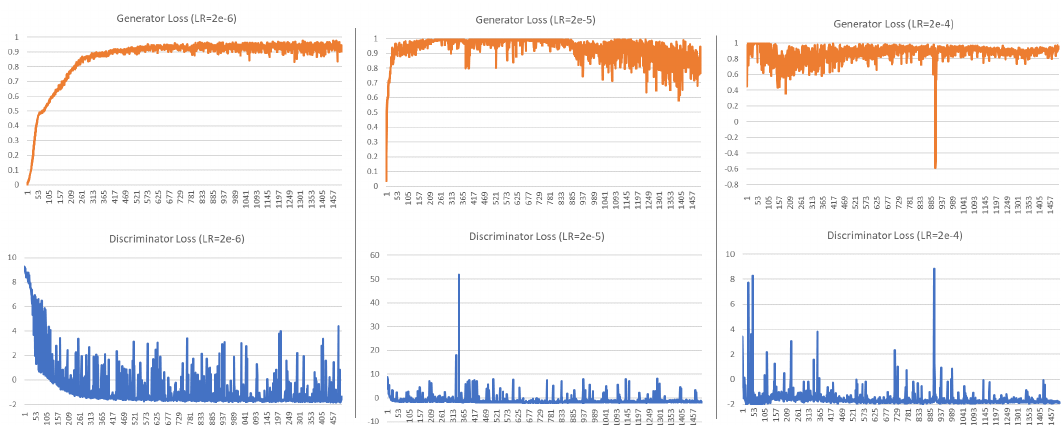
Figure 9. Generator and discriminator loss for LR = 2 × 10 − 6 , 2 × 10 − 4 , and 2 × 10 − 4 (UCI data